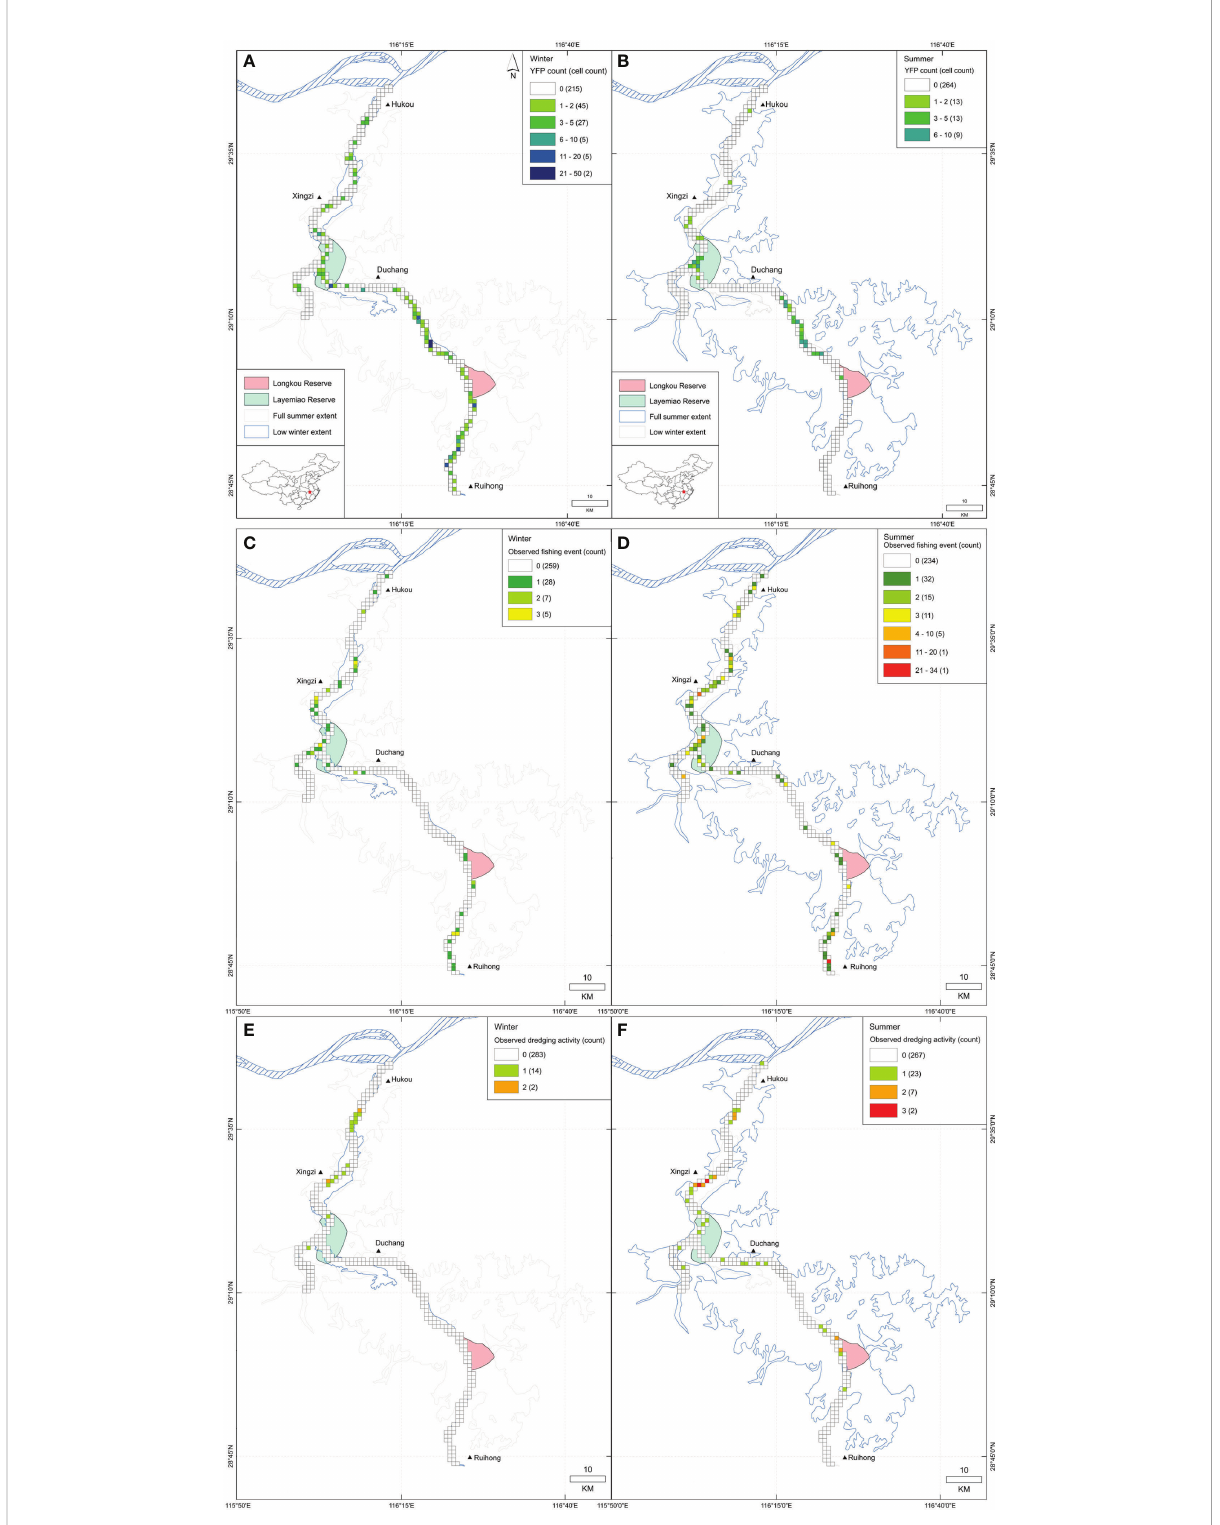
FIGURE 2 Observations of (A, B) porpoises, (C, D) fi shing activity, and (E, F) sand-mining activity in Poyang Lake during winter (A, C, E) and summer ( B, D, F